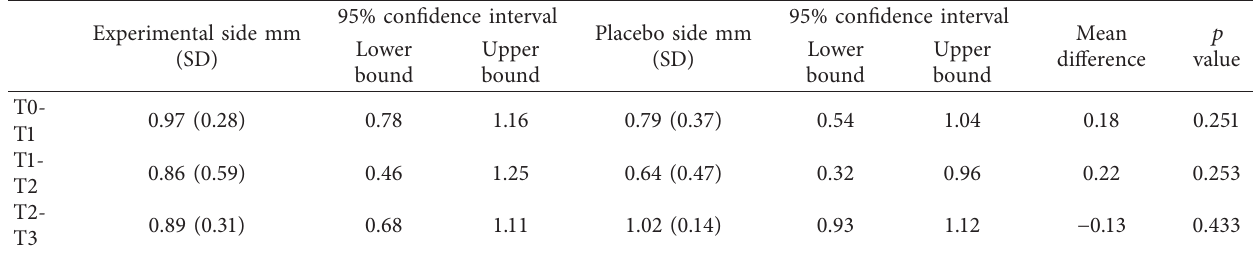
Table 1: Mean values and standard deviation of canine movements in experimental and placebo groups with confidence interval and p values.